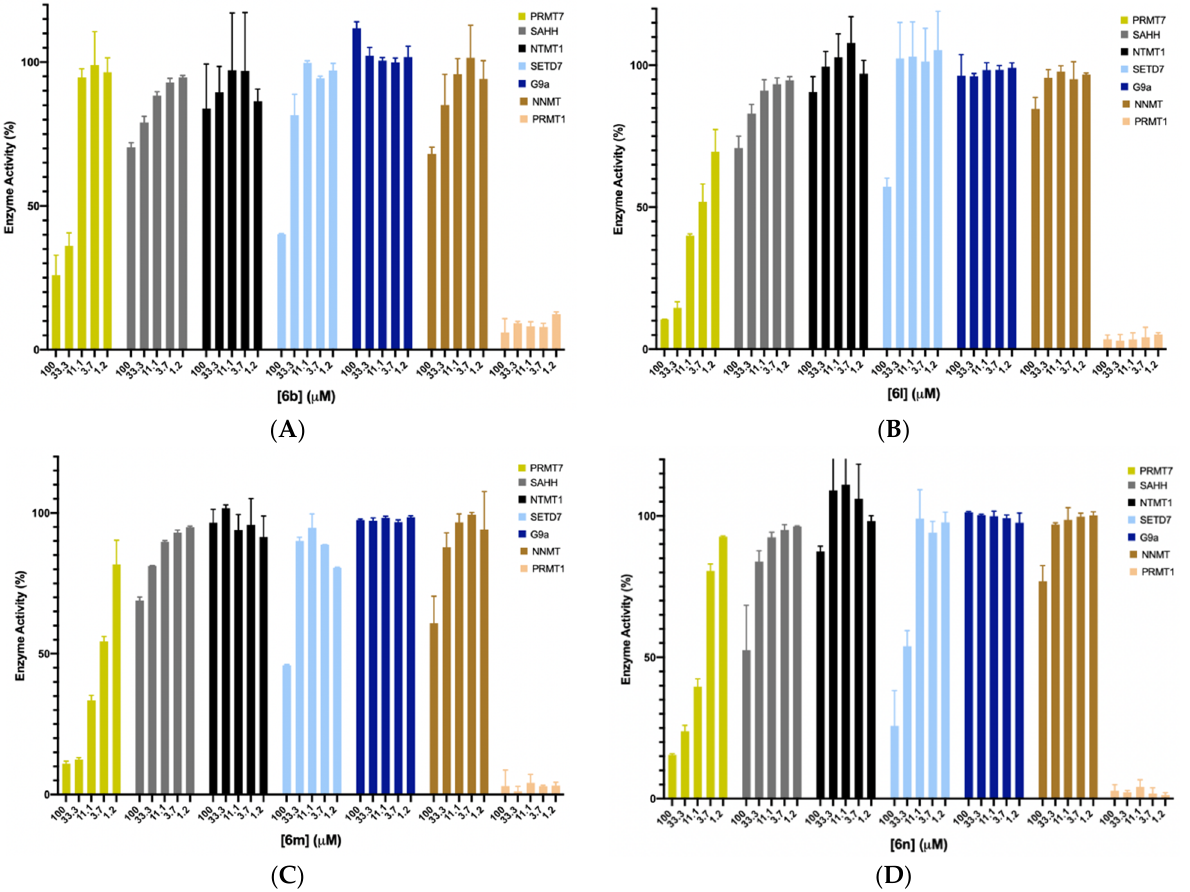
Figure 5. Selectivity studies for compounds 6b ( A ) and 6l – n ( B – D ) against Tb PRMT7, SAHH, NTMT1, SETD7, G9a, and NNMT with each compound at five different concentrations (100, 33, 11, 3.7, and 1.2 µM). All experiments were performed in duplicates (n = 2).